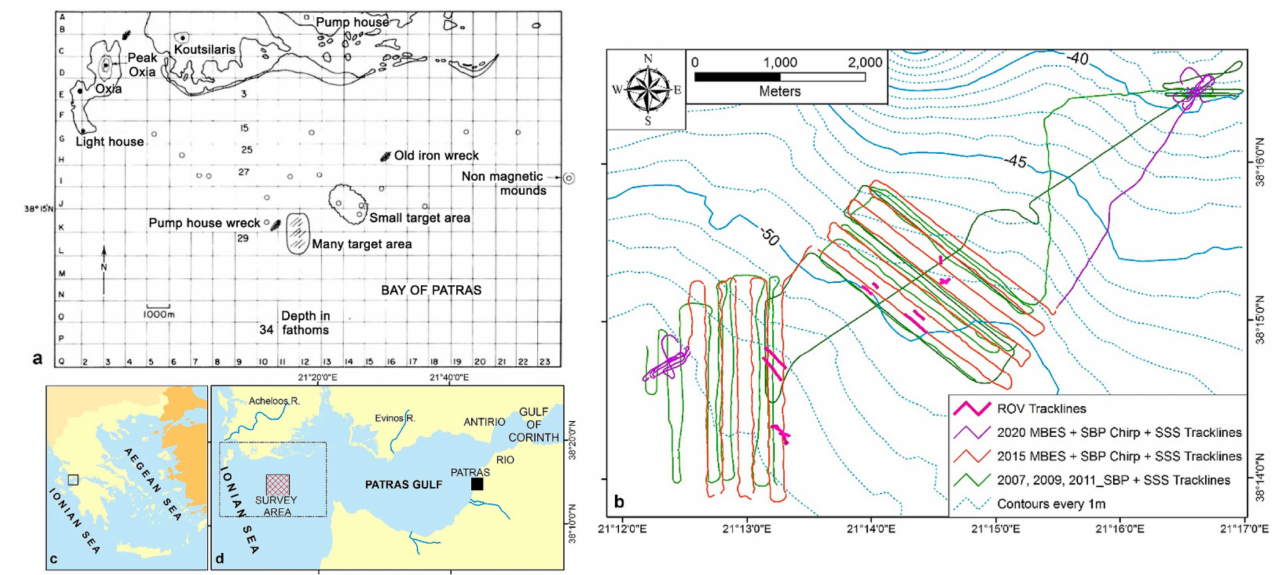
Figure 1. ( a ) Map published by Throckmorton et al. (1973): (121, Figure 1) showing the “many target” and “small target” areas and the “pump house” and “old iron” wrecks. ( b ) Bathymetric map showing the 3.5 kHz, Chirp and side-scan sonar track lines and the R.O.V. transect in the survey areas at the western part of the Patras Gulf. ( c , d ) Sketch maps of Greece and Patras Gulf showing the study area (shaded rectangular) and the area corresponding to the map of Figure